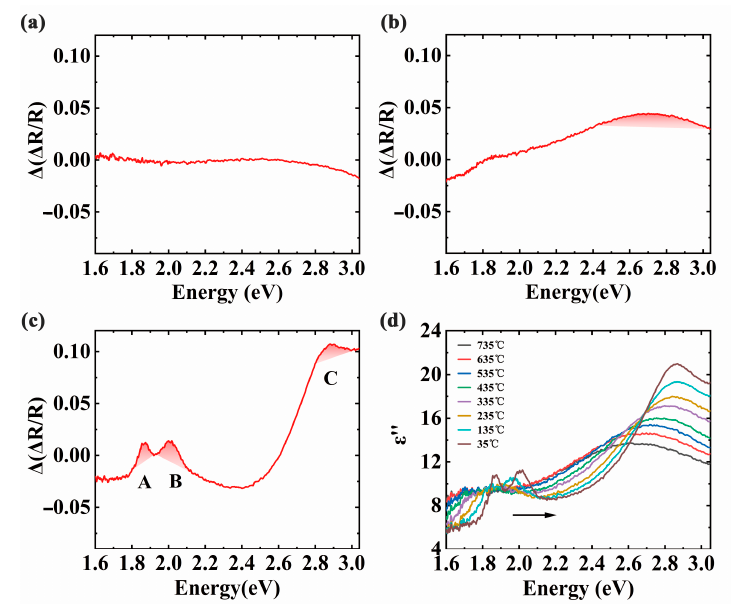
Figure 3. ( a – c ) The increments of DRS during heating, holding and cooling section for the CVD growth, respectively. A, B, and C represent three characteristic peaks of MoS 2 at different energy, respectively; ( d ) The imaginary part values ε '' of MoS 2 dielectric constant per 100 °C during the cooling section. The arrow indicates the direction of the peak as the temperature decreases.